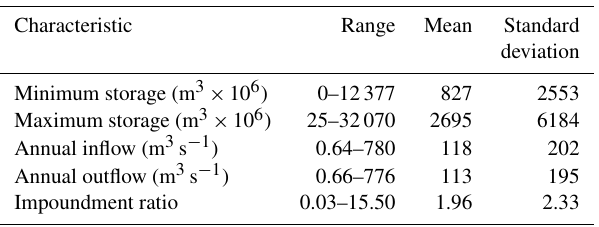
Table 2. Select statistical characteristics of reservoirs analyzed in this